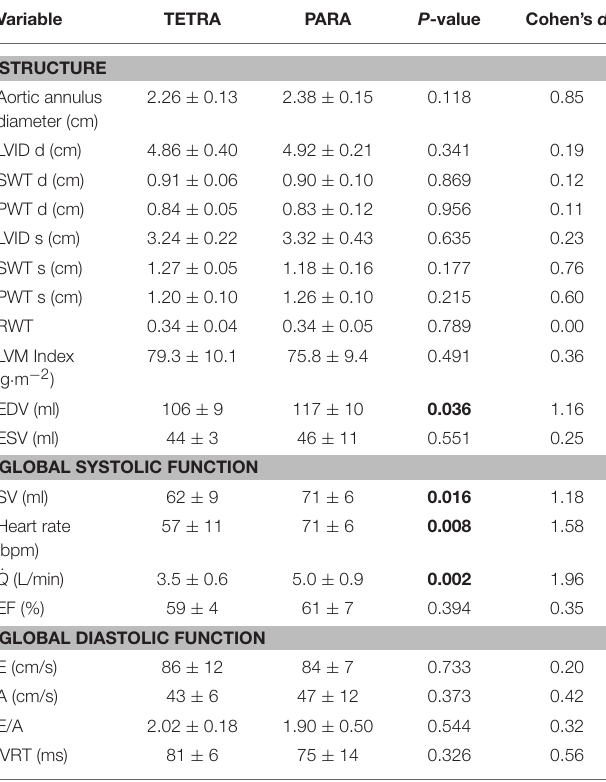
TABLE 2 | Indices of LV structure and global systolic and diastolic function. Variable